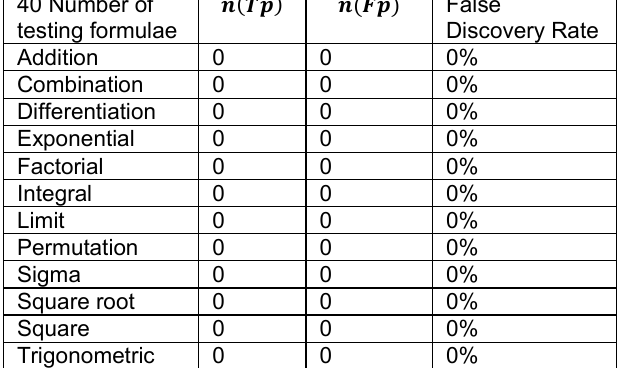
Table 14. The above tabulated value represents overall FPR Measure with Tensorflow from a document of 40 samples.